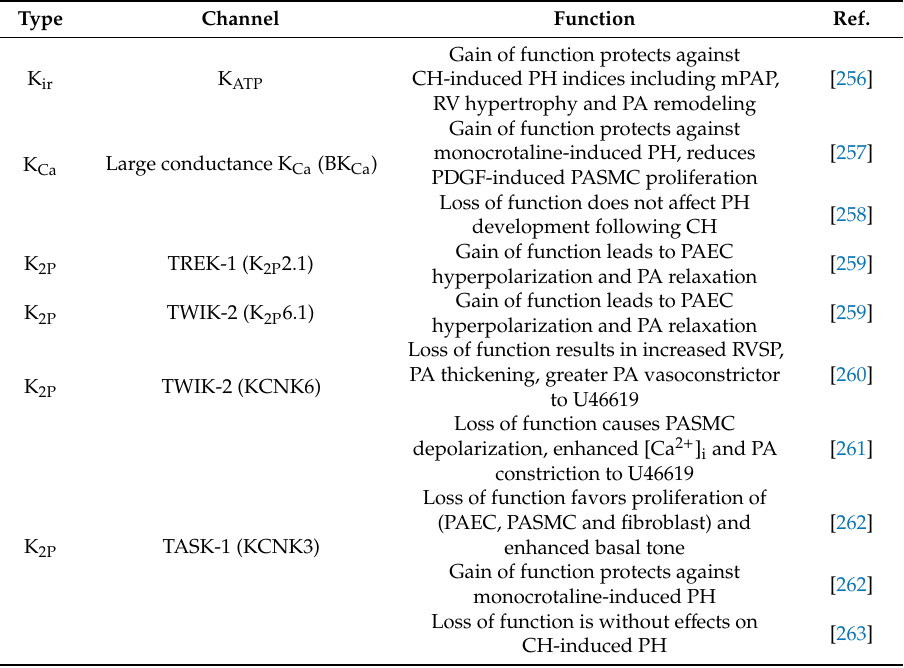
Table 4. Other K + channels involved in CH-induced PH or